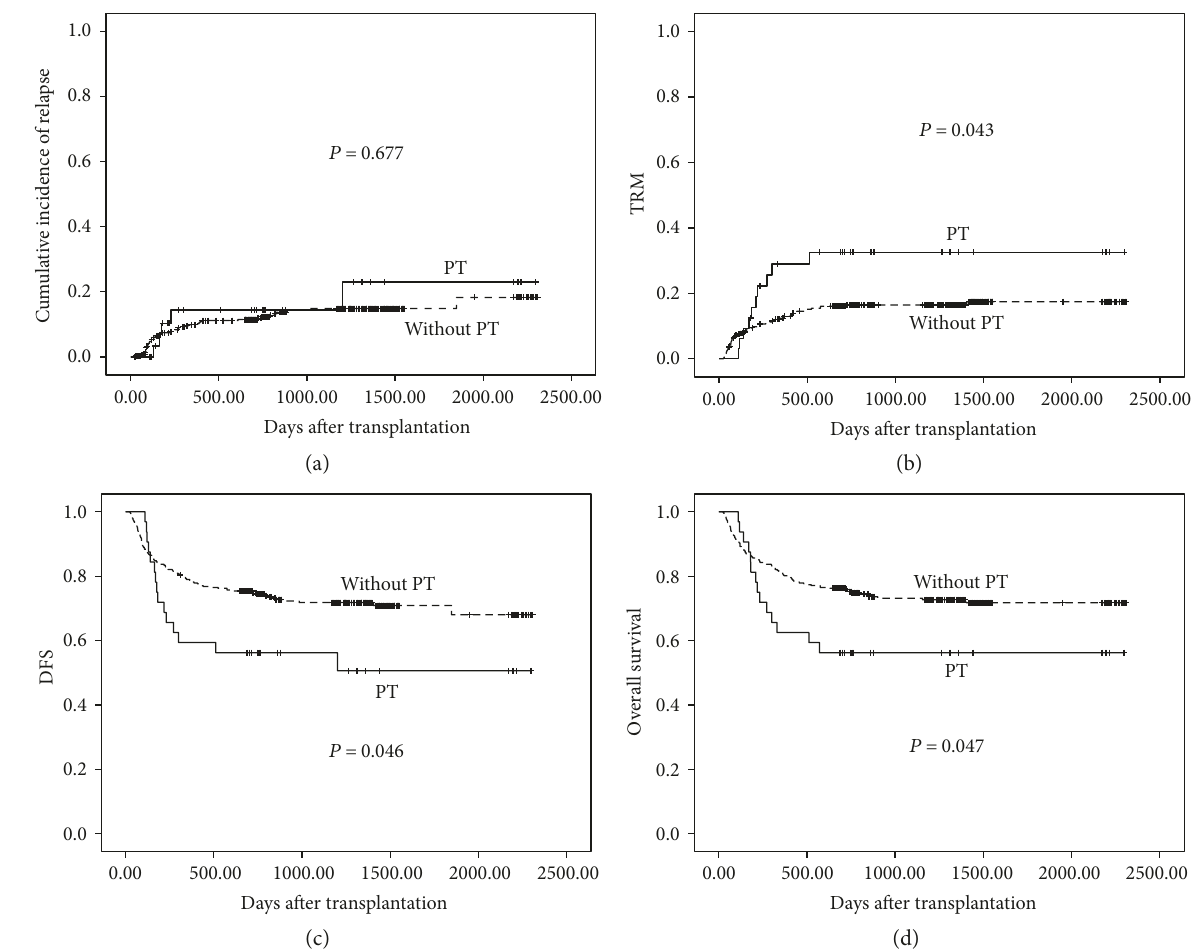
Figure 1: PT and transplant outcomes after haploidentical transplantation. (a) Cumulative incidence of relapse (CIR) and (b) TRM. (c) Disease-free survival. (d) Overall